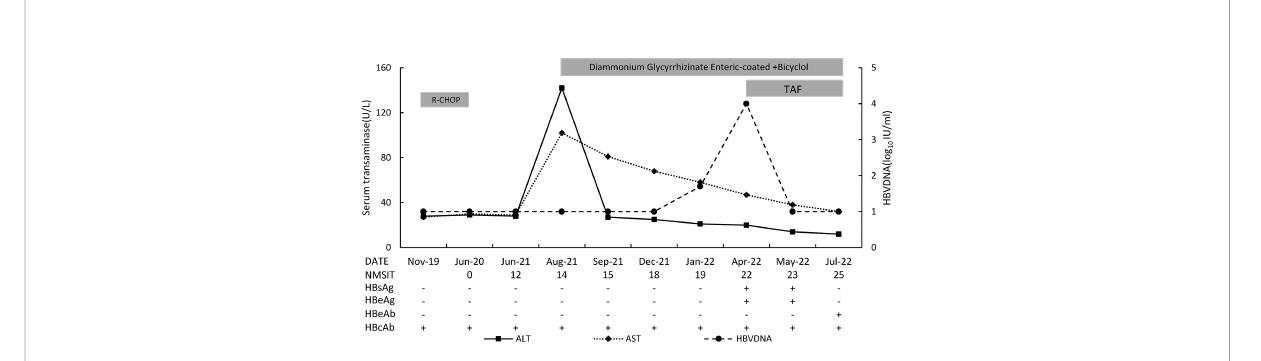
FIGURE 1 The sketch map of this patient. NMSIT: the number of months after stoping immunosuppressive